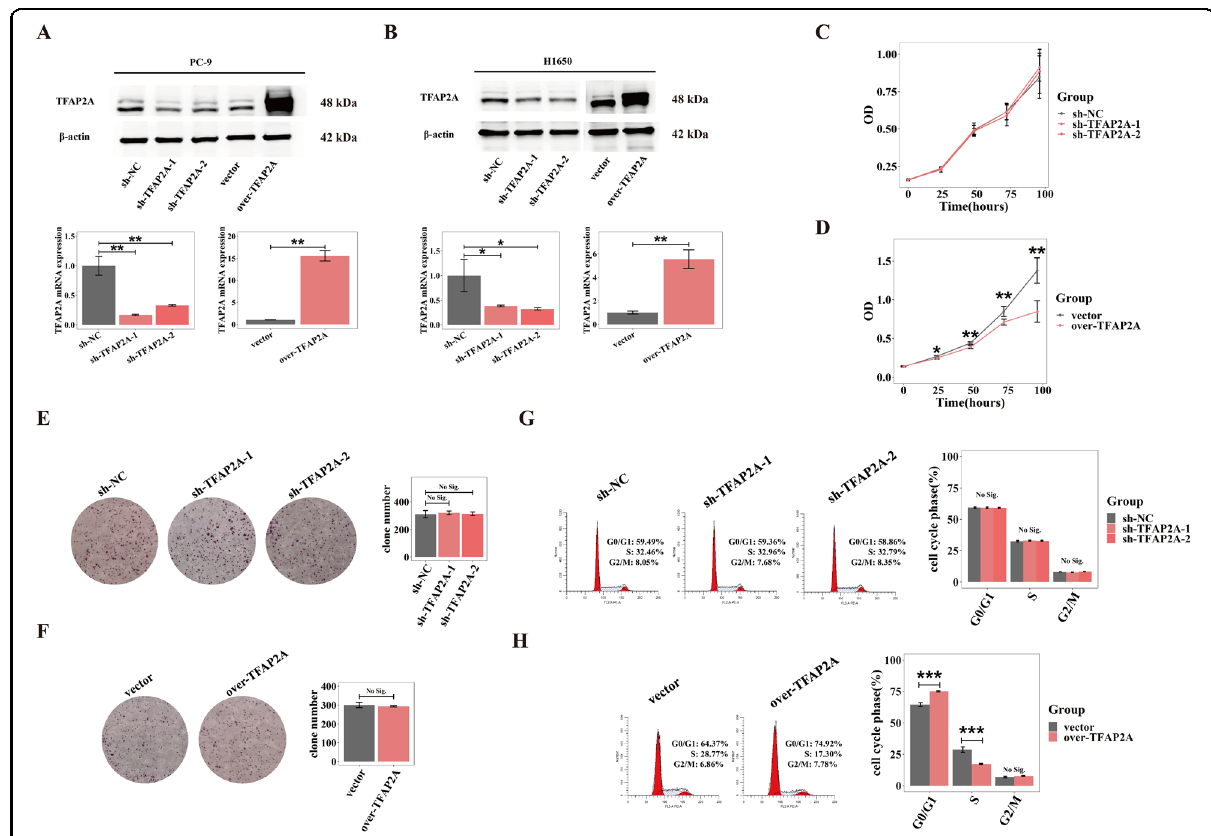
Fig. 3 TFAP2A could not facilitate or even inhibit LUAD proliferation. A , B Protein expression (up) and transcript levels (down) of TFAP2A for TFAP2A knockdown and overexpression cell models of PC-9 ( A ) and H1650 ( B ) (stable gene interference and overexpression by recombinant lentiviruses). C , D Proliferation curves assessed by CCK8 assay during 96 h for TFAP2A knockdown and overexpression cell models of PC-9 ( C , knockdown vs. control; D , overexpression vs. control). E , F Plate cloning and statistical analysis for TFAP2A knockdown and overexpression cell models of PC-9 ( E , knockdown vs. control; F , overexpression vs. control). G , H Effects on cell cycle progression for TFAP2A knockdown and overexpression cell models of PC-9 ( G , knockdown vs. control; H , overexpression vs. control). * p < 0.05; ** p < 0.01; *** p < 0.001. N ≥ 3, Data are presented as mean ± standard deviation